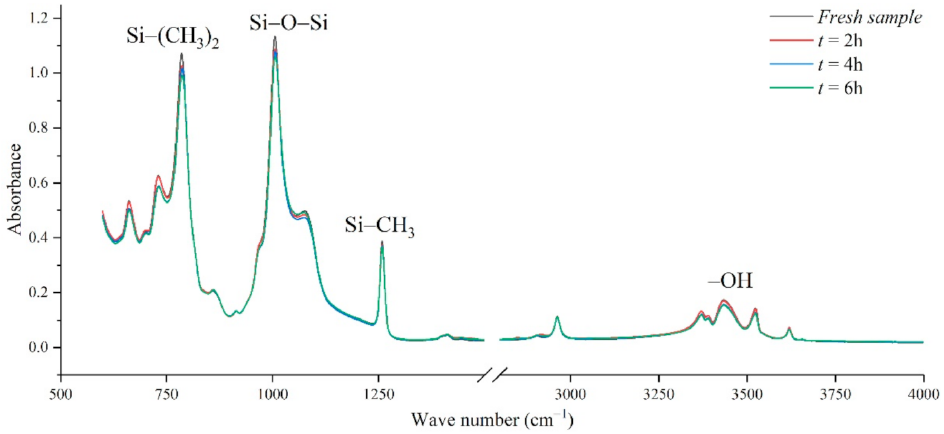
Figure 10. FTIR test results of different test times (AC 3.08 kV, pH =